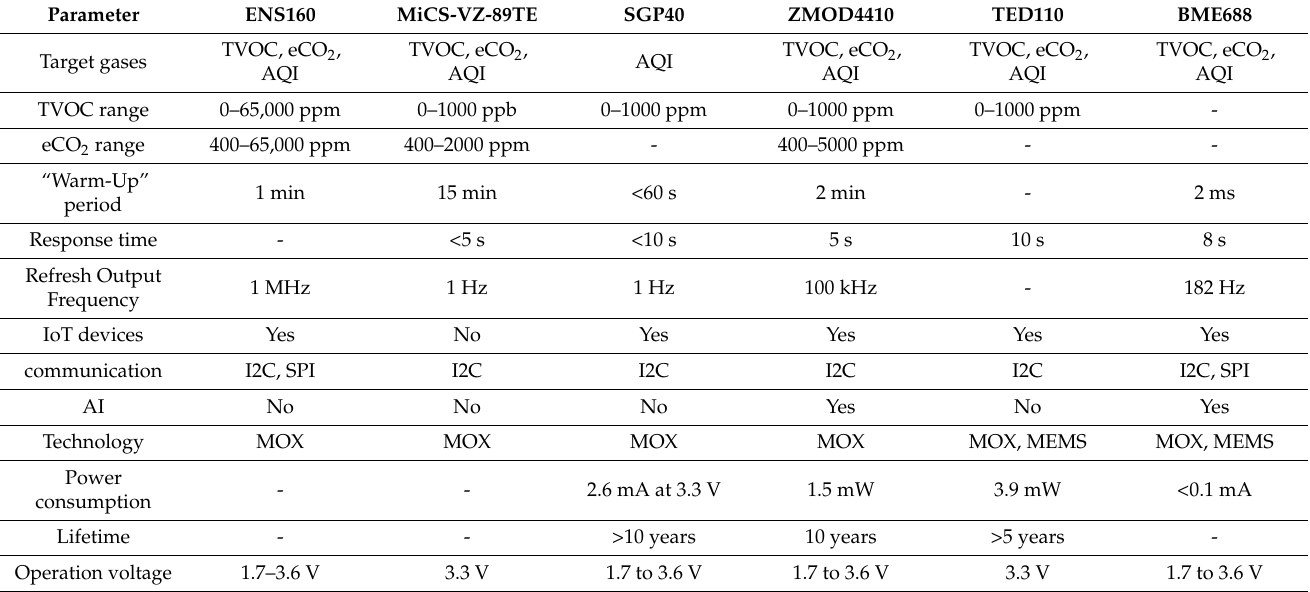
Table 2. New in market available gas